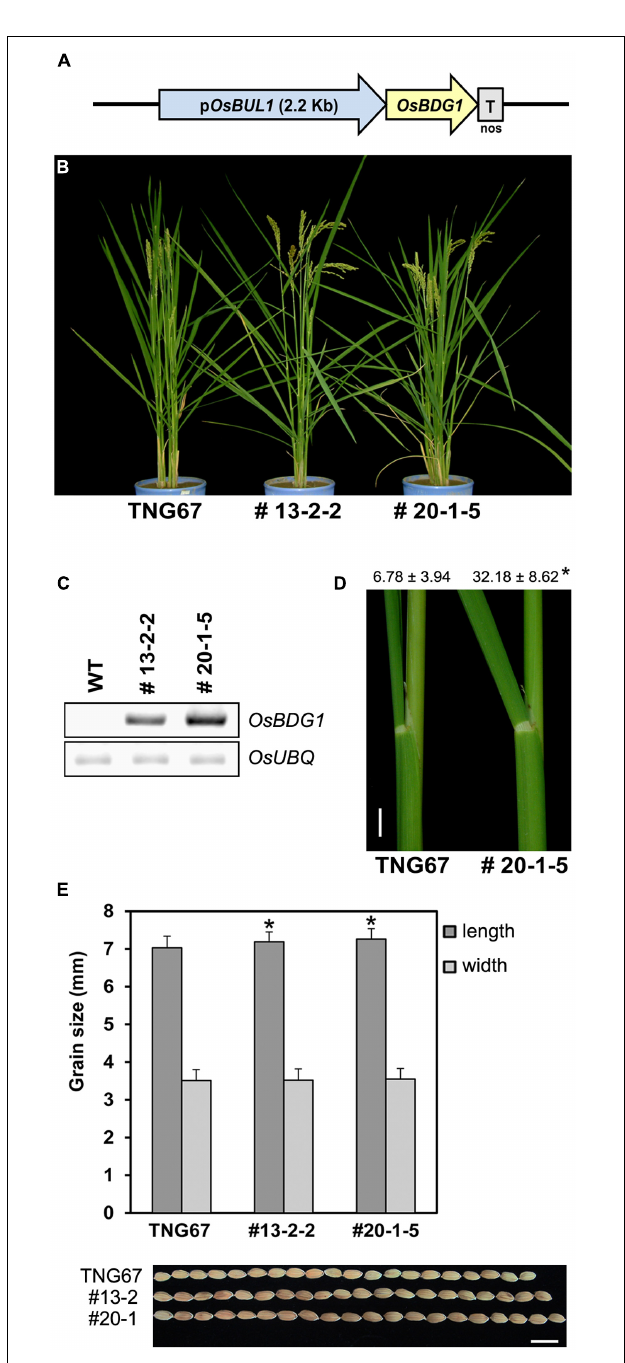
FIGURE 4 | Phenotypic alterations of p OsBUL1 : OsBDG1 transgenic rice plants. (A) A simplified structure of p OsBUL1 : OsBDG1 construct. (B) Transgenic lines with p OsBUL1 : OsBDG1 construct exhibited conspicuous increase of leaf angles. (C) Expression of OsBDG1 in collar between WT and transgenic plants. Semi-quantitative RT-PCR was conducted for OsBDG1 expression in transgenic rice plants together with WT. Twenty-six PCR cycles for both OsBDG1 and OsUBQ were applied. (D) Degree of leaf angles between WT and transgenic line, #20-1-5 at the second leaf from the top of the main stem. Values are given as means ± SD (degree; n > 14). ( ∗ P < 0.01, Student’s t -test). Bar = 1 cm. (E) Transgenic lines produced grains with increased size. ( ∗ P < 0.01, Student’s t -test). Bar = 1